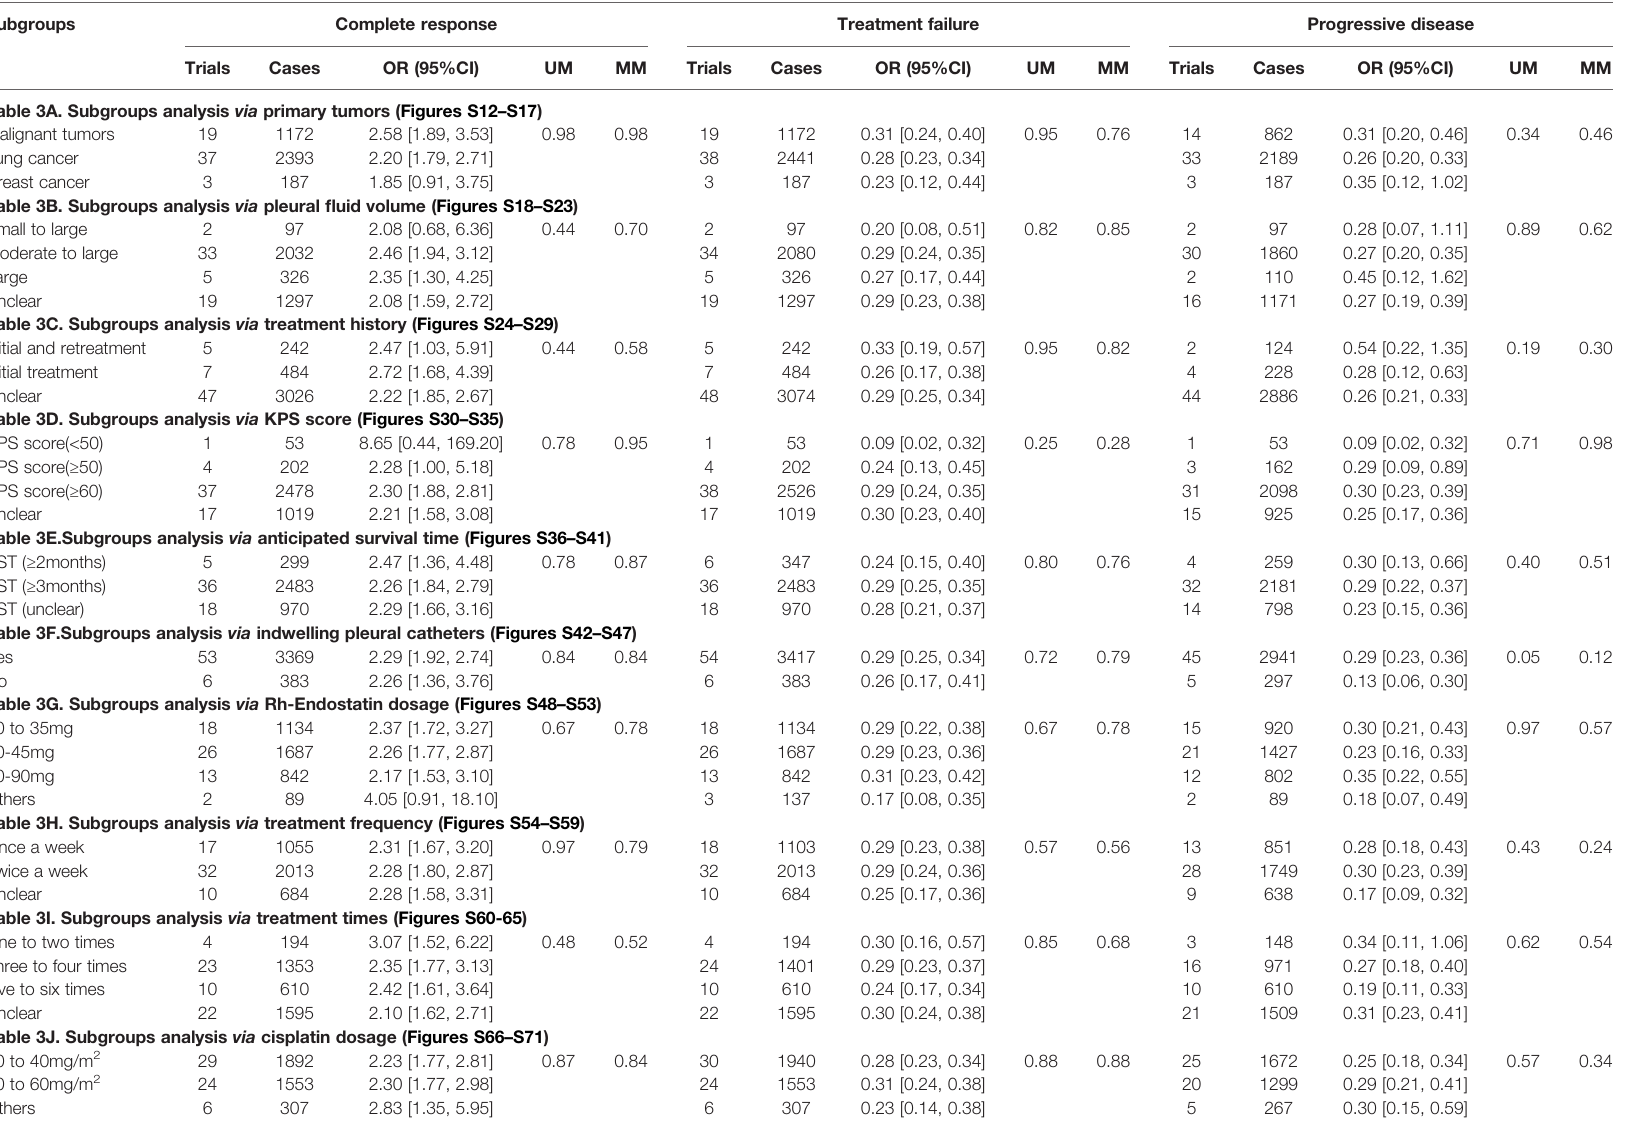
TABLE 3 | Subgroup analysis results ( Supplementary Materials 6A, B ).